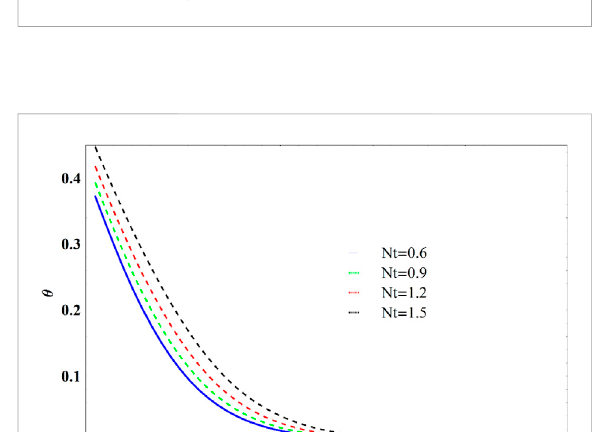
FIGURE 15 Disparity of Q on θ